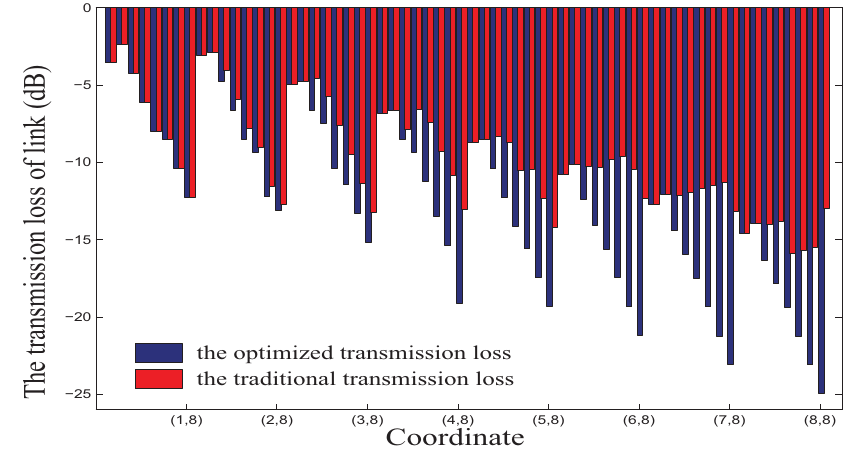
Figure 6. The transmission loss in M × N mesh-based